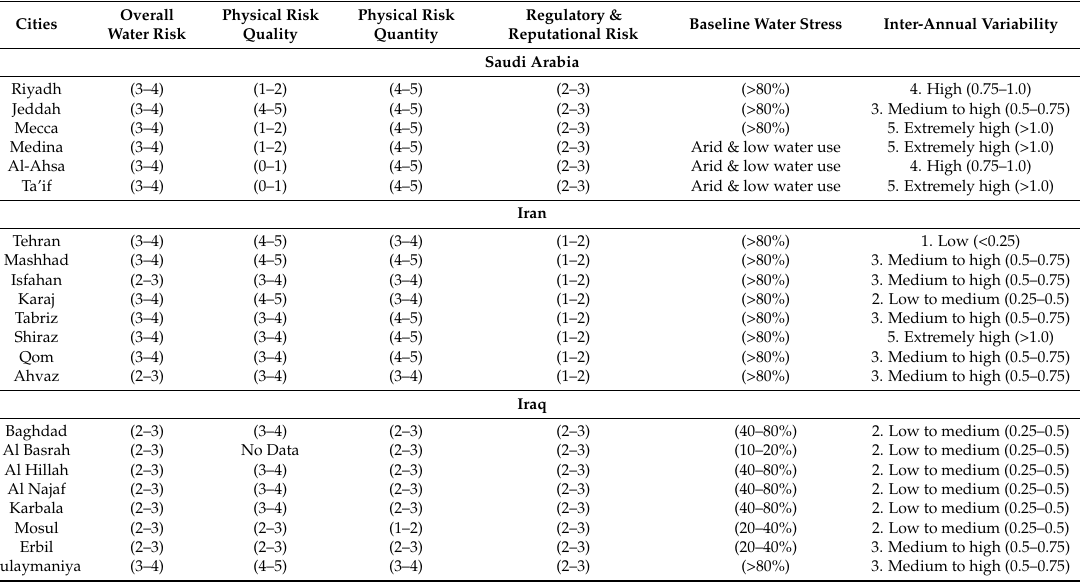
Table 1. Risk for selected Middle Eastern cities with populations greater than one